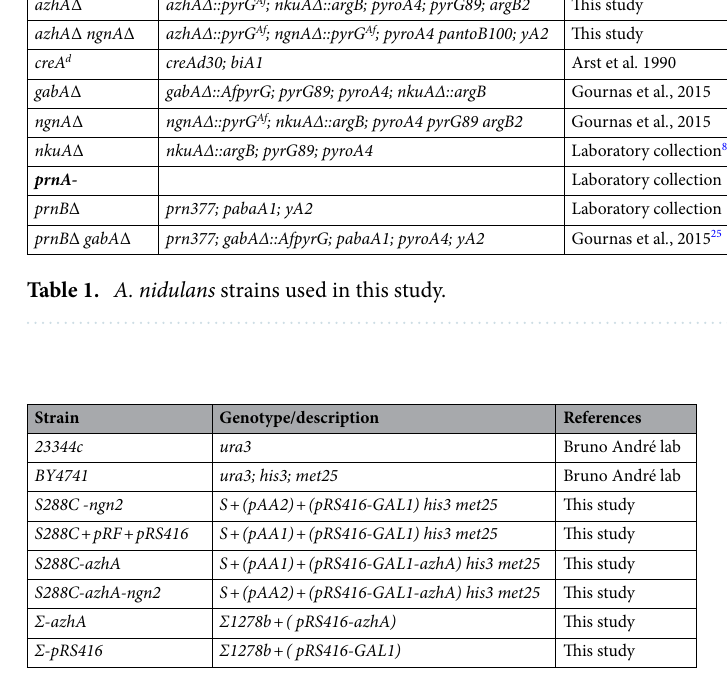
Table 2. S. cerevisiae strains used in this study.